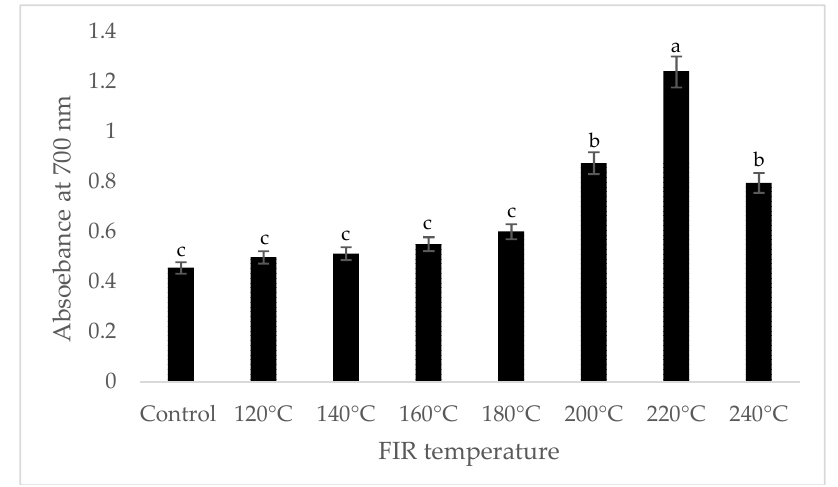
Figure 3. Reducing power of A. gigas Nakai treated by FIR irradiation (FRAP assay). Values are the mean ±SD ( n = 3). Different lowercase letters within the row indicate significant differences ( p <0.05) according to ANOVA. FIR: far infrared irradiation.